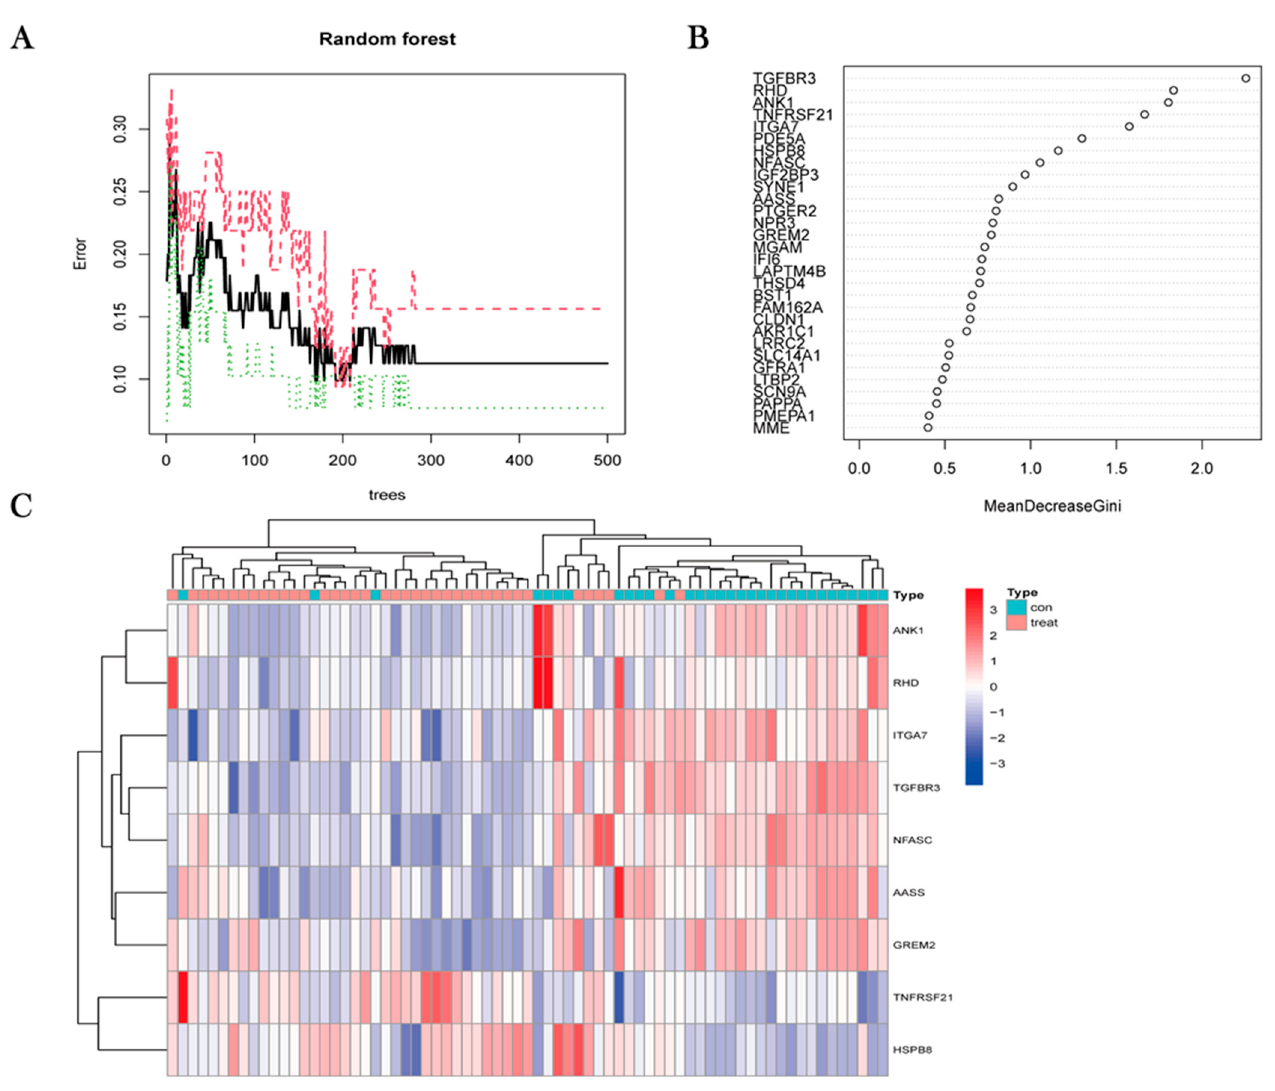
Figure 5. ( A ) Representative genes were identified by random forest. The total number of trees is represented on the x -axis, and the rate of error is represented on the y -axis. ( B ) The top 30 representative genes of importance were identified according to the random forest algorithm. ( C ) The unsupervised clustering heatmap shows the hierarchical clusters formed by the nine representative genes created by random forest in the combined dataset.